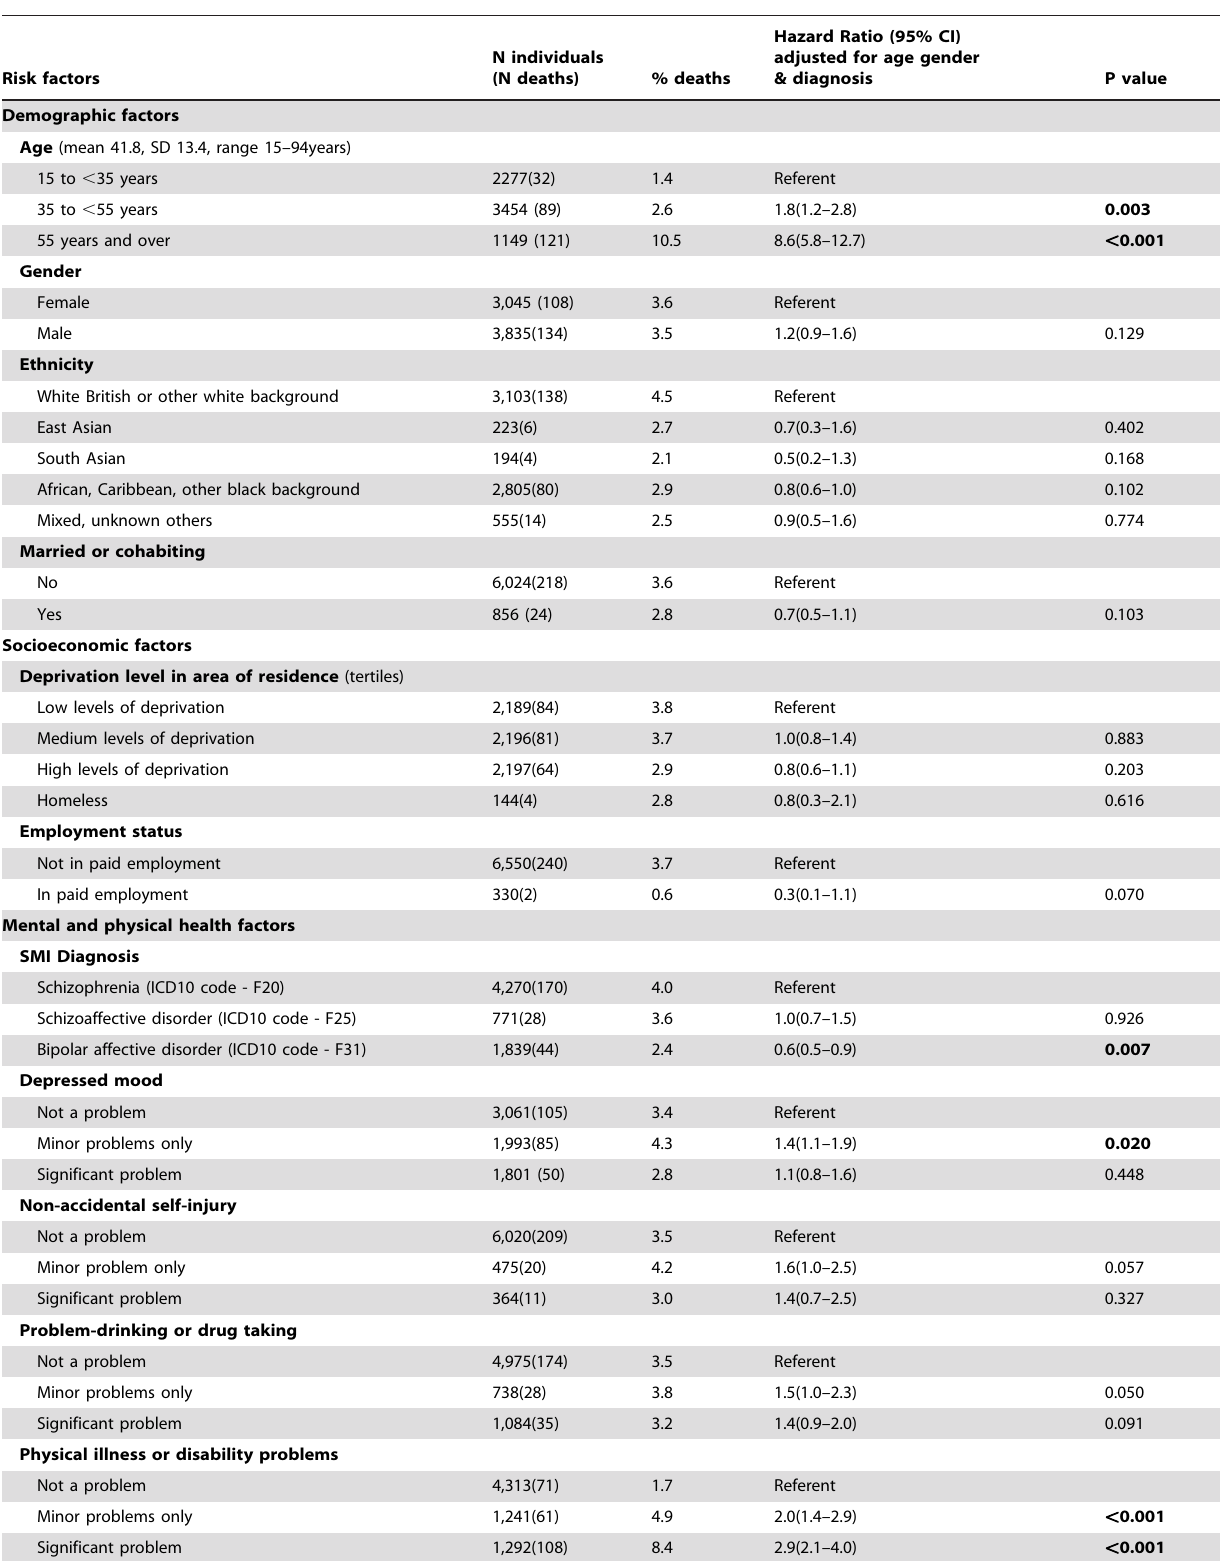
Table 1. Cox regression analyses of risk factors for all cause mortality in individuals with serious mental illness (N =6,880, 242